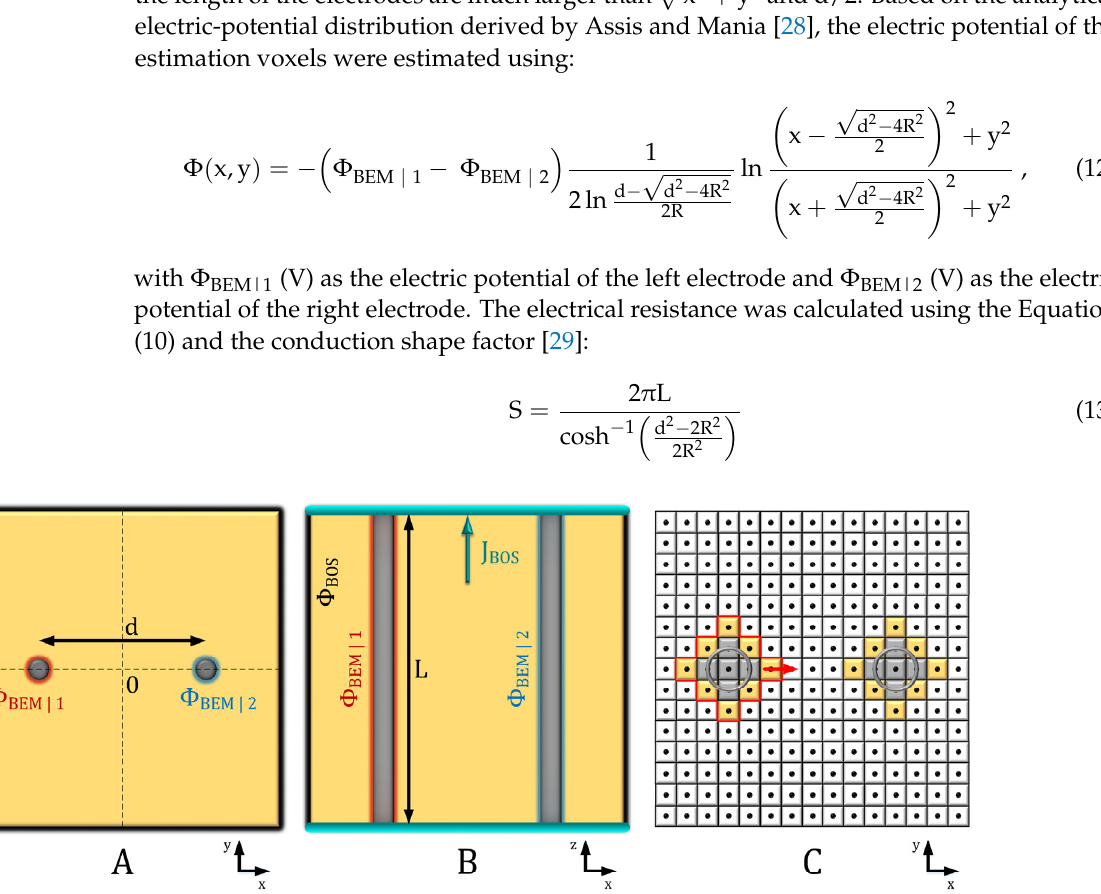
Figure 4. ( A ) The transverse plane of cylindrical electrode model. The boundaries at the outer surface of the domain model (BOS) were assumed to be Φ BOS = 0 V. The modeling domain has an equilateral dimension in the x,y-plane. ( B ) The coronal plane of the model with the electrode of length L interposed between two isolation layers (colored aqua blue), through which J BOS = 0 A · m − 2 . ( C ) Discretization of the electrodes (represented by the circular lines). Electrode voxels are grey and their corresponding estimation voxels are represented by the orange voxels. The red contour represents the surfaces of the voxels that were used to calculate the electrical